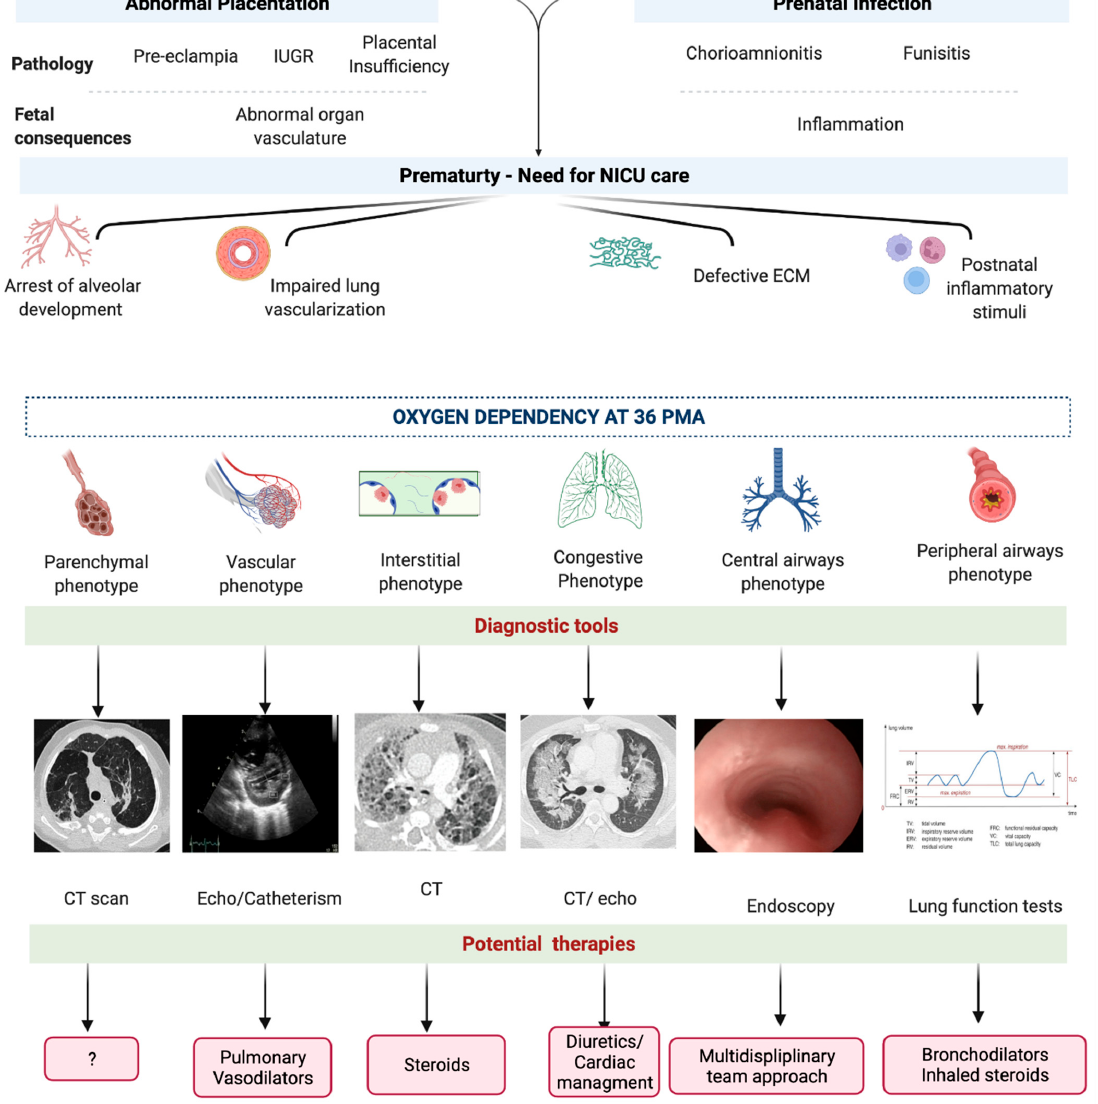
Figure 5. Diagnostic and therapeutic perspectives on phenotypes of bronchopulmonary dysplasia. Abbreviations : intrauterine growth restriction (IUGR), extra-cellular matrix (ECM), computed tomography (CT). Created with BioRender.com.